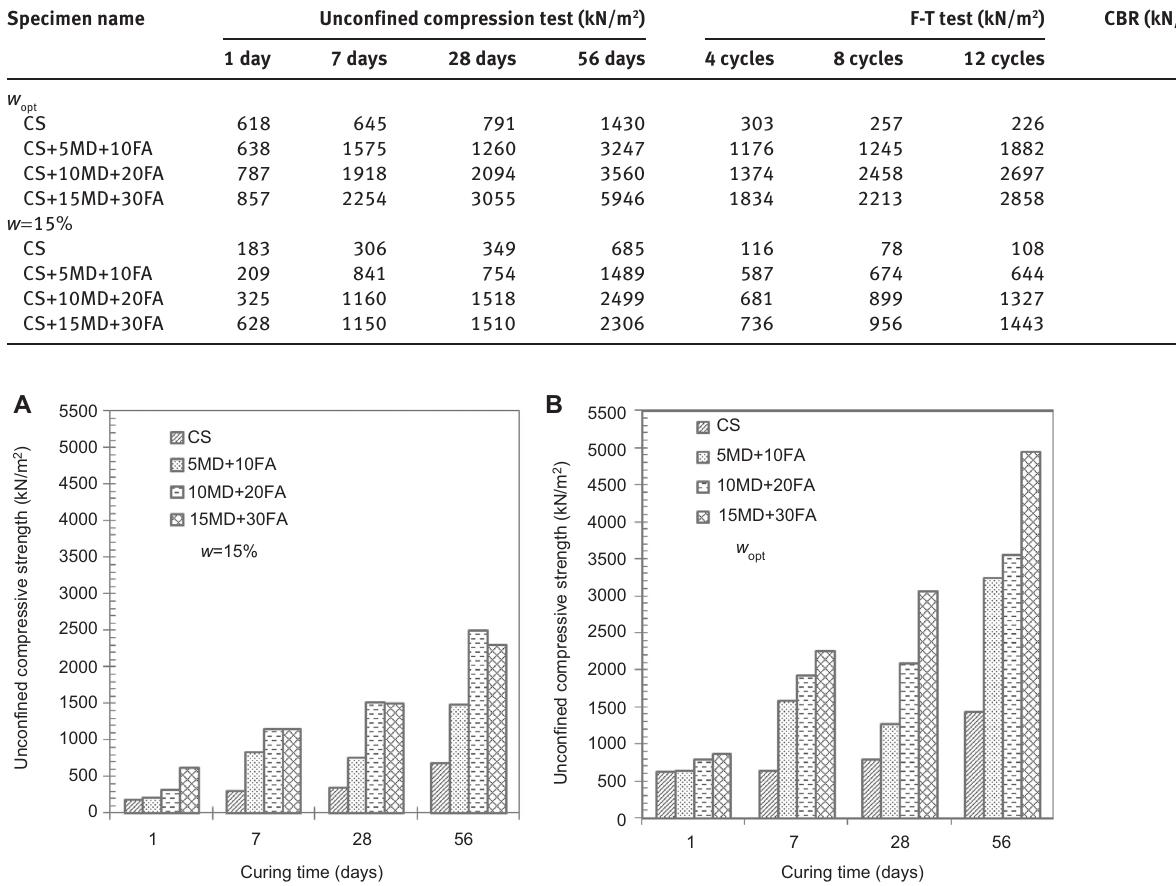
Figure 1 Effects of additive materials and curing time on unconfined compressive strength of mixtures (A) At the specimens with prepared w = 15% and (B) At the specimens with prepared w opt